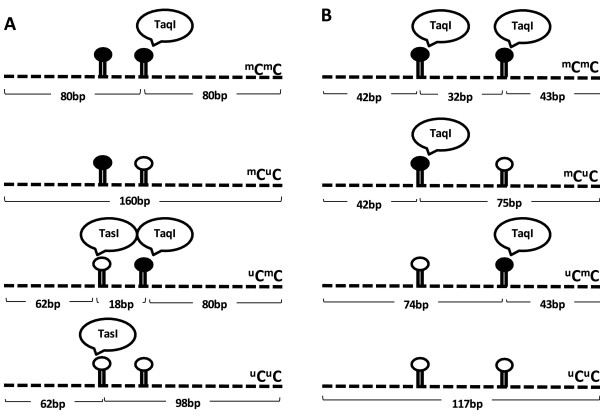
LINE-1 and Alu methylation patterns. The dark circles represent methylated cytosine, while the hollow circles represent unmethylated cytosine. There are four possible methylation patterns for the LINE-1 and Alu amplicons, including hypermethylated loci (mCmC), hypomethylated loci (uCuC), and 2 partially methylated loci (mCuC and uCmC). In each model, TaqI specifically identified methylated cytosine, while TasI specifically identified unmethylated cytosine. (A) The different methylation patterns of LINE-1 resulted in four differently sized digested products of 160 bp, 98 bp, 80 bp and 62 bp. (B) The different methylation patterns of the Alu element resulted in four differently sized digested products of 117 bp, 74/75 bp, 42/43 bp and 32 bp.